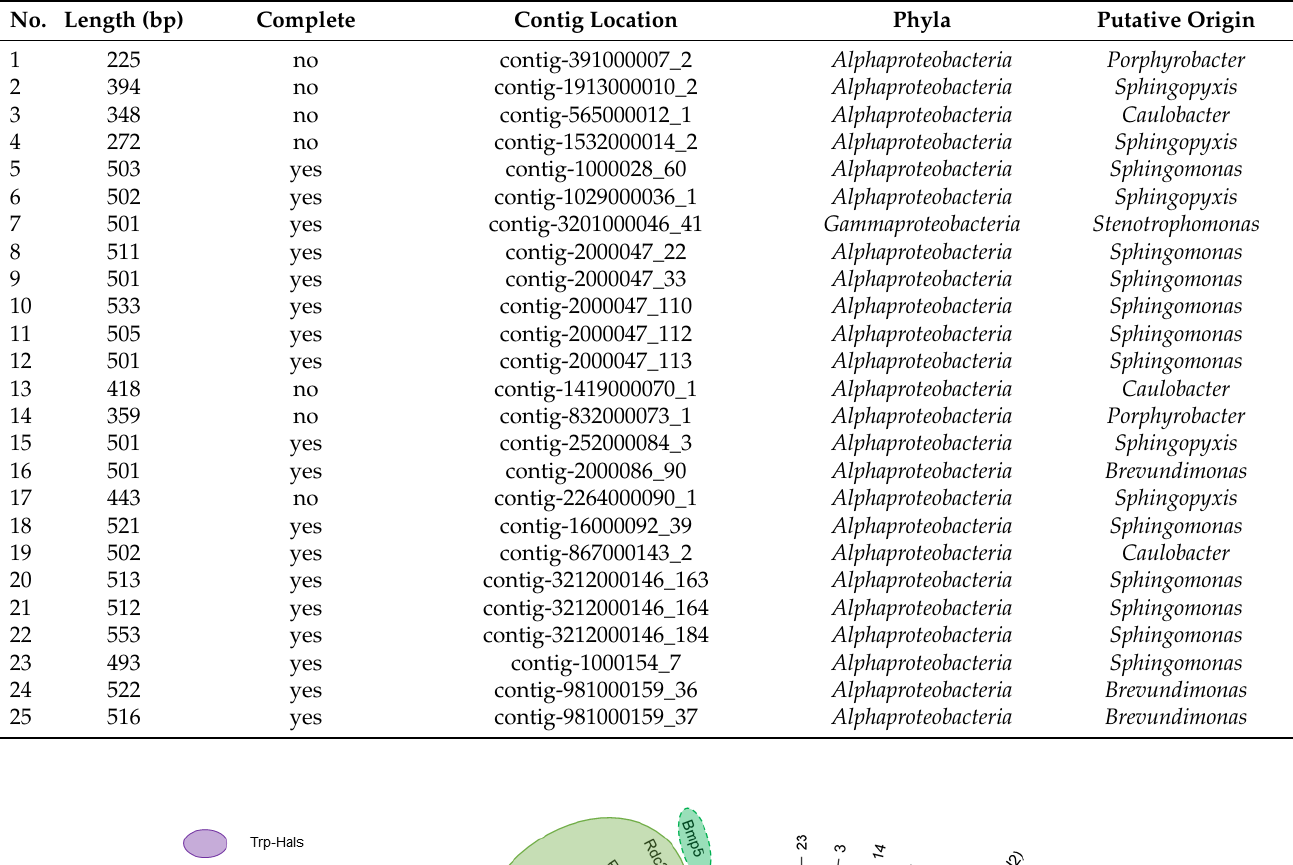
Table 1. Newly found putative, flavin-dependent halogenases with the conserved amino acid motif of Trp halogenases and their taxonomic assignment, based on BLAST analyses (https://blast.ncbi.nlm.nih.gov; Basic Local Alignment Search Tool).